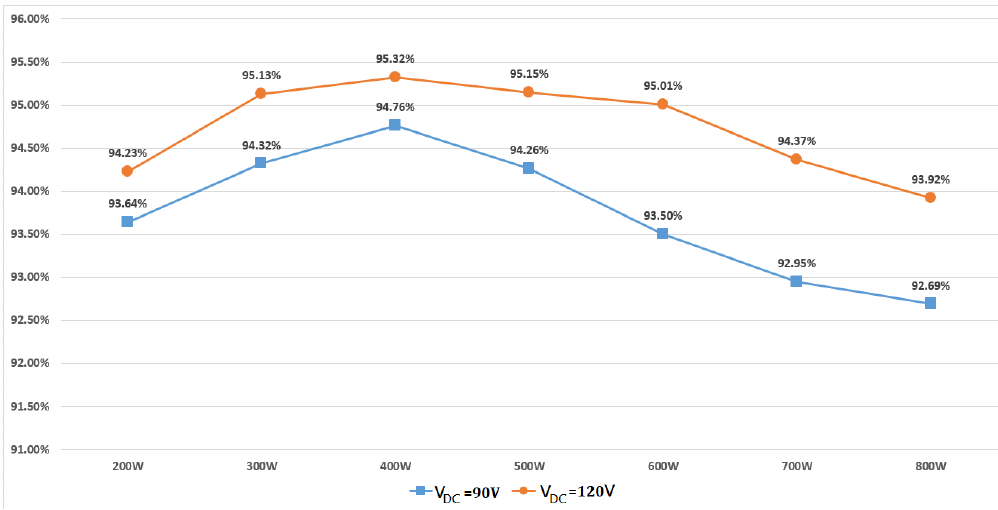
Figure 17. Power efficiency of the BBI.